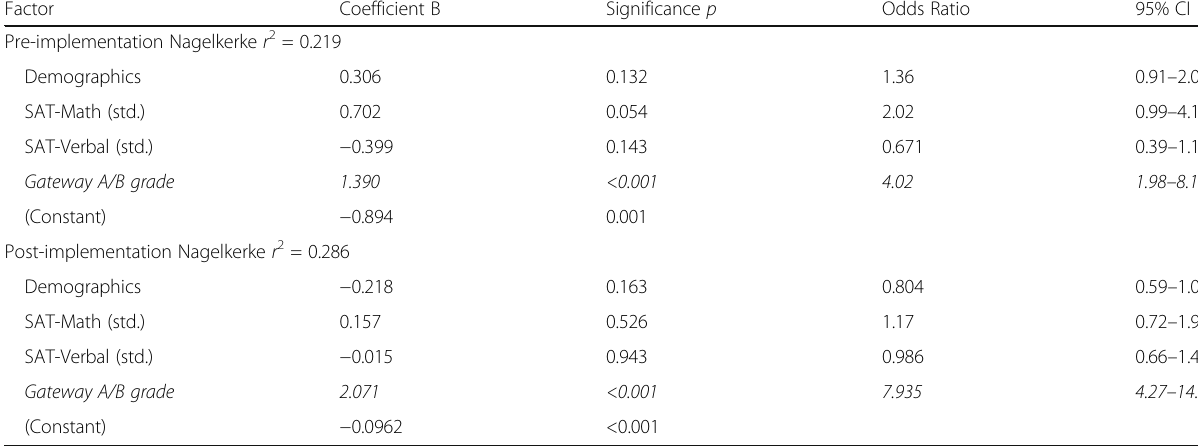
Table 7 Logistic regression coefficients with dependent variable STEM retention after two years. Gateway A/B grades are the only significant predictor of STEM retention, and its effect size does not significantly differ pre- to post-implementation